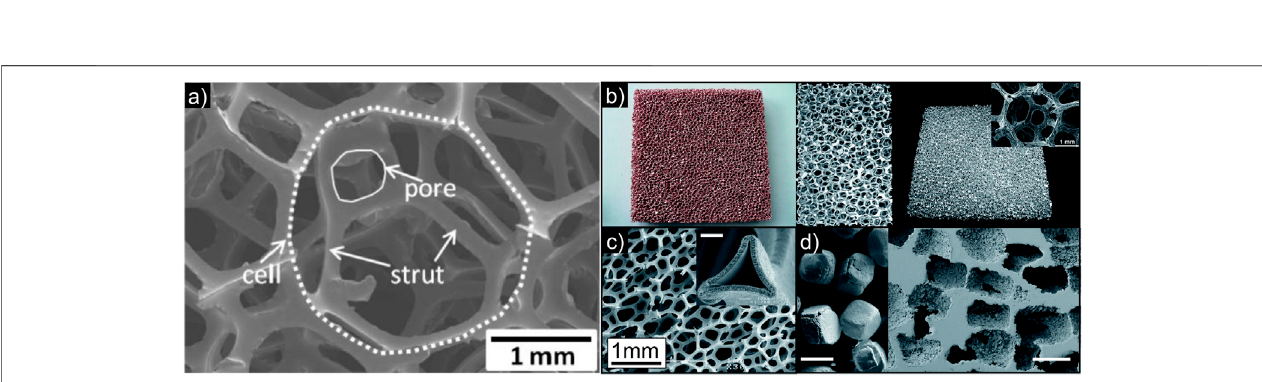
FIGURE2| High-magni fi cationdetailofthecellstructureofanopencellfoam (A) (Zhangetal.,2012)).Examplesofopencellfoams:Duocel ® copperandaluminum basedfoams (B) ,Incofoam ® nickelfoampreparedbyreplicationtechnique (C) andtitaniumopenporousmaterialpreparedwiththespaceholderapproach (D) (Kränzlin and Niederberger, 2015).